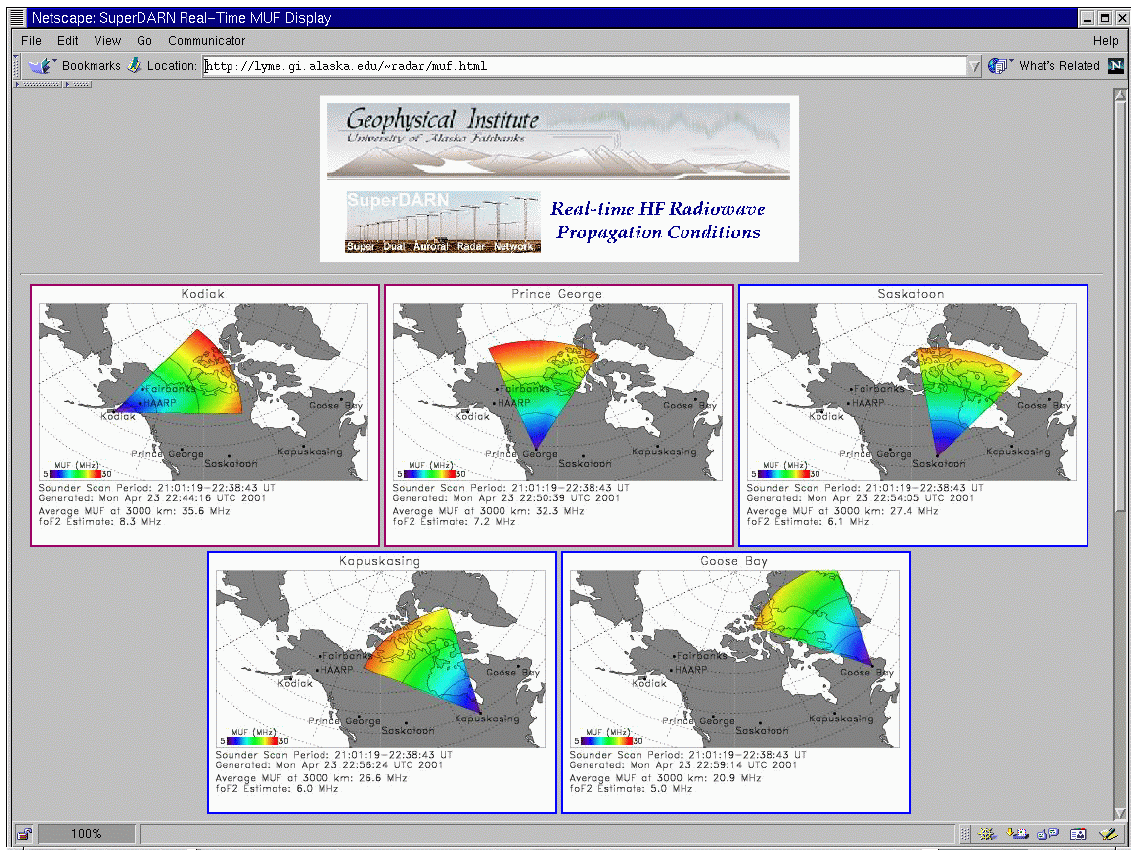
Fig. 4. World Wide Web page display using synthesized data showing near-real-time MUF and overhead ionospheric critical frequency estimates for five Northern Hemisphere SuperDARN radars. The user can activate links on this page to obtain more detailed information about each